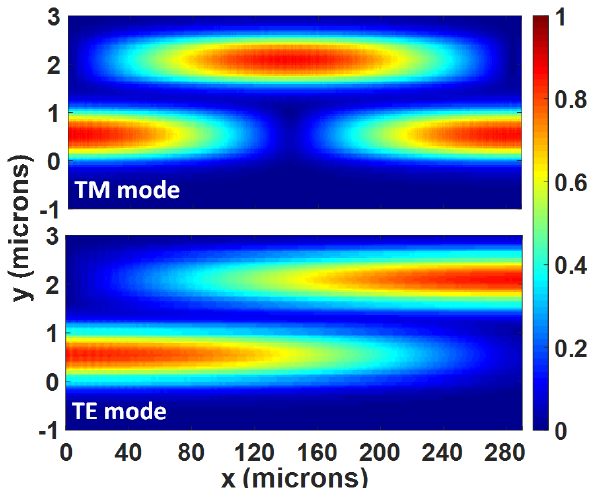
Figure 8. The power evolutions of the quasi-TM and quasi-TE modes in the designed PBS at 1550 nm.